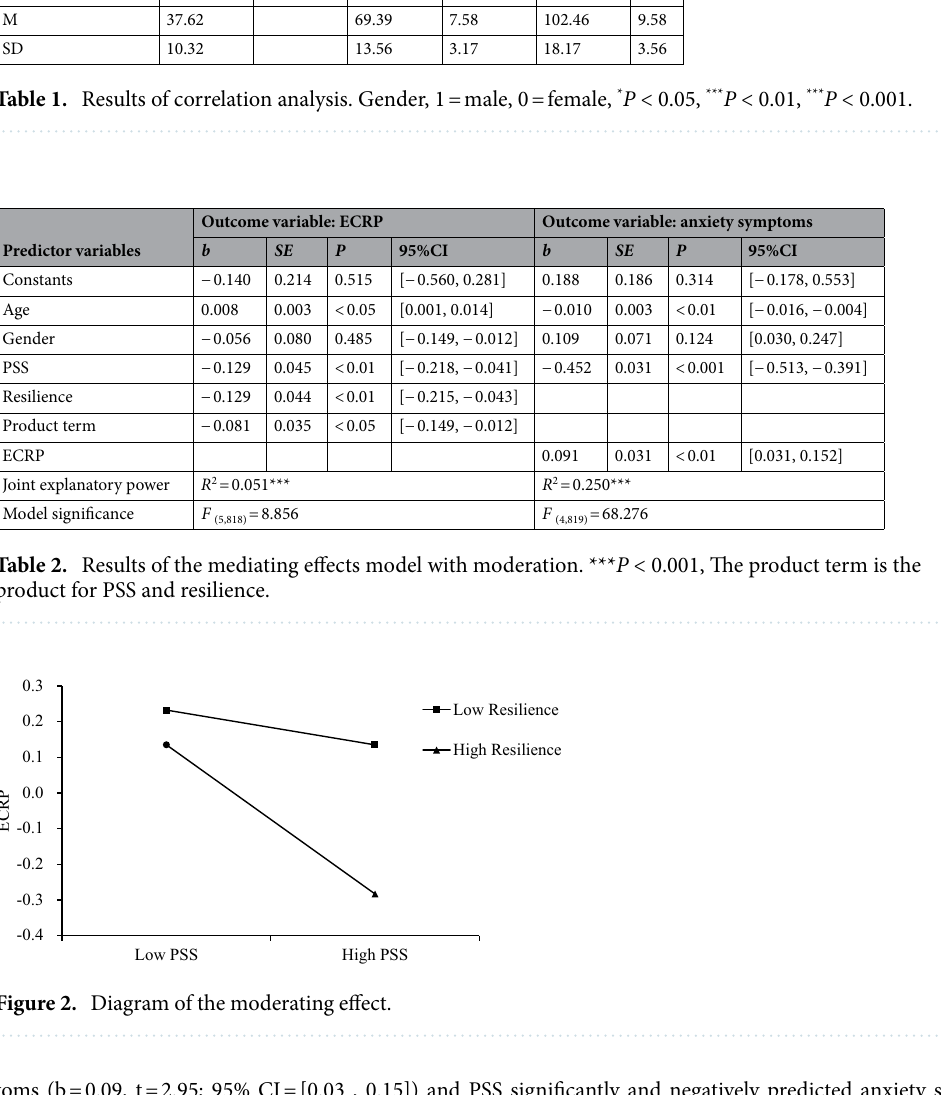
Table 2. The interaction term between PSS and resilience was a significant predictor of ECRP (b = − 0.08, t = − 2.31; 95% CI = [− 0.15, − 0.01]), and thus the moderating effect of resilience was significant. To more clearly explain the substance of the interaction effect between resilience and social support, resilience was grouped high and low by the next one standard deviation, a simple slope test was conducted and a simple effect analysis plot was drawn (Fig. 2). The results showed that individuals with high resilience had significantly lower emotional per- ceptions of epidemic risk with increasing levels of PSS (b = − 0.21, t = − 3.25; 95%CI = [− 0.34, − 0.08]); whereas individuals with low resilience had non-significant changes in ECRP with increasing levels of PSS (b = − 0.05, t = − 1.01; 95% CI = [− 0.14, − 0.04]). Taken together, the moderated model with mediation constructed in this